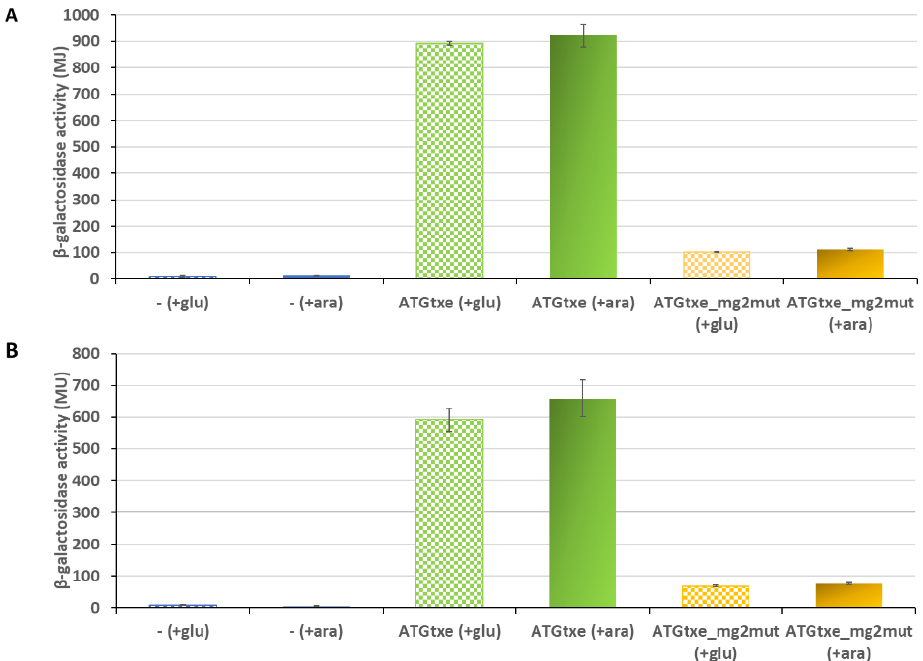
Figure 4. The influence of minigenes supplied in trans on reporter protein activity. β -galactosidase activities were assessed in the E. coli ∆ 5 ∆ lac strain carrying empty pRW225 vector ( − ) as control, or its derivatives, as indicated on the graph, together with pBAD33_mg2 ( A ) or pBAD33_mg1,2 ( B ) bearing DNA fragment containing minigenes under the p BAD promoter. Expression of the minigenes was induced by the addition of 0.2% L-arabinose (+ara), or repressed by 0.2% glucose (+glu) at the time of inoculation. Reporter activity was measured when cell cultures reached OD600 ≈ 0.5. These results are the average of at least three independent experiments; error bars represent standard deviation (S.D.).